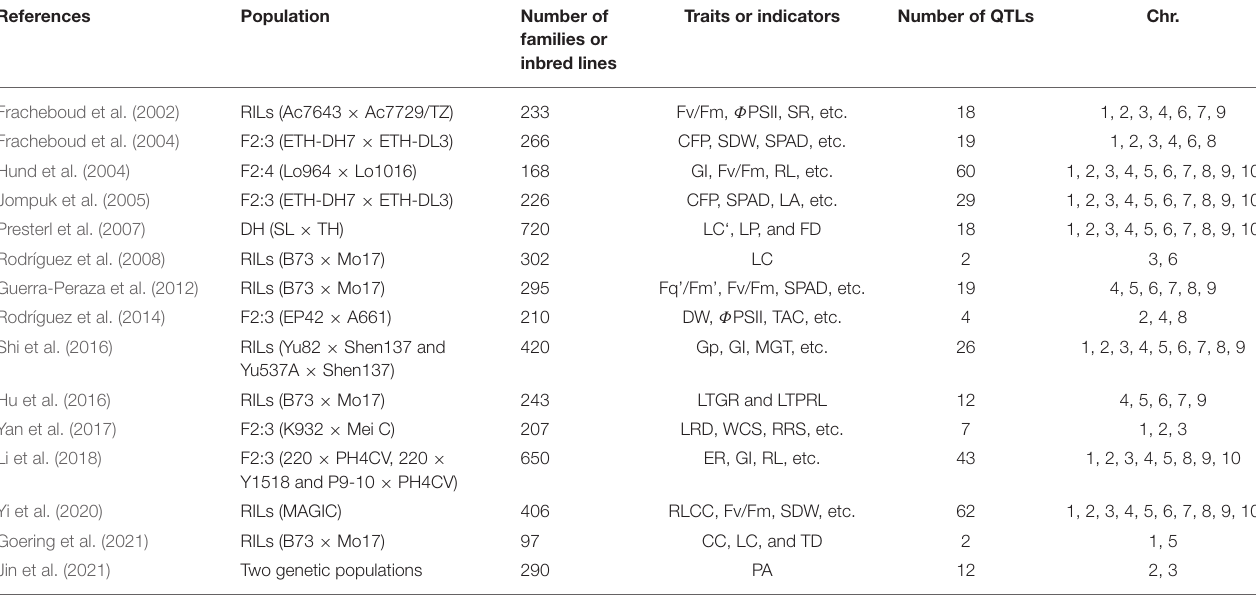
TABLE 1 | Quantitative trait loci (QTLs) for traits related to cold tolerance in maize.